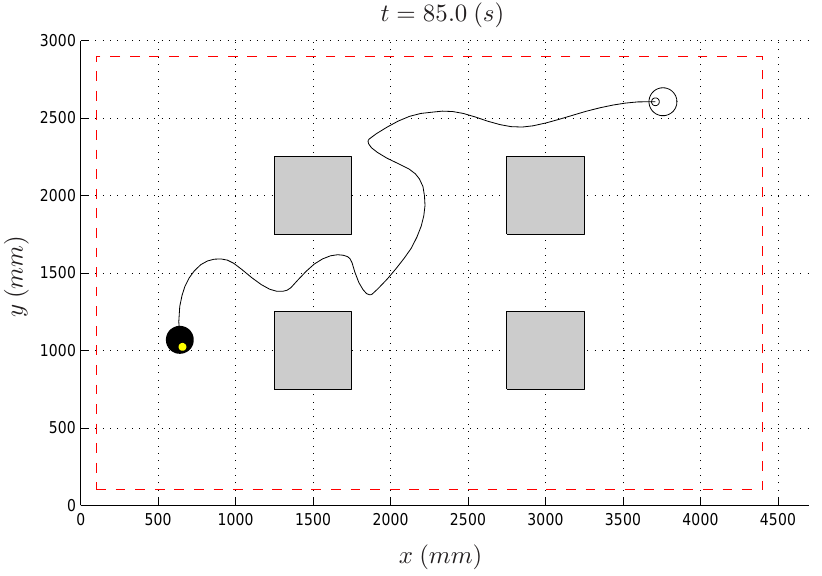
Figure 17. Collision avoidance: single-robot and four obstacles (shaded regions): initial robot pose (empty circle), final robot pose (filled circle), robot path (solid